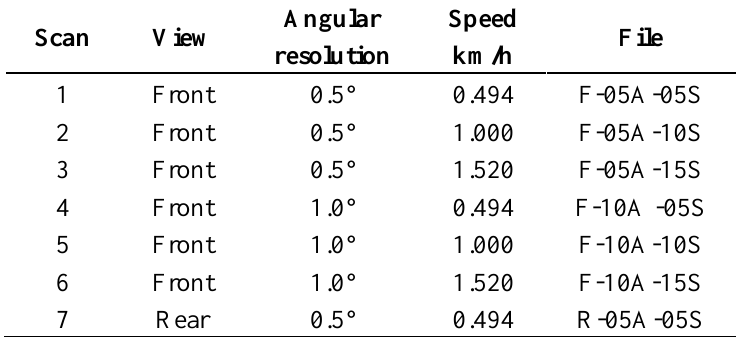
Table 1. Rear and front view scans of the Ficus benjamina specimen with angular resolutions of 0.5° and 1°, and approximate forward speeds of 0.5, 1 and 1.5